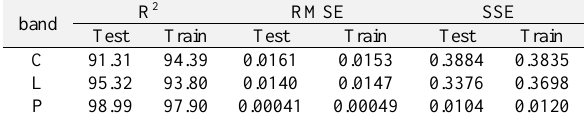
Table 3. Results of SVR model with all features with optimizing SVR parameters